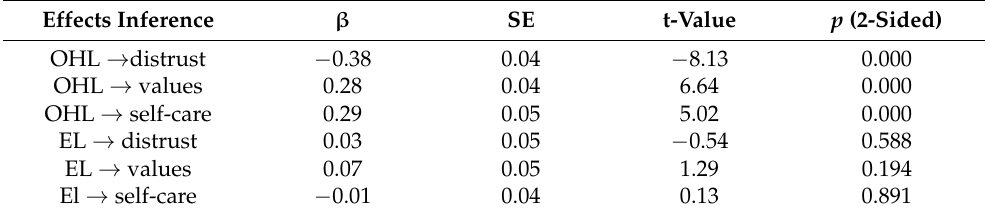
Table 6. The inference of the effects of knowledge on values, attitudes, and behaviours regarding oral health; female sample (N =